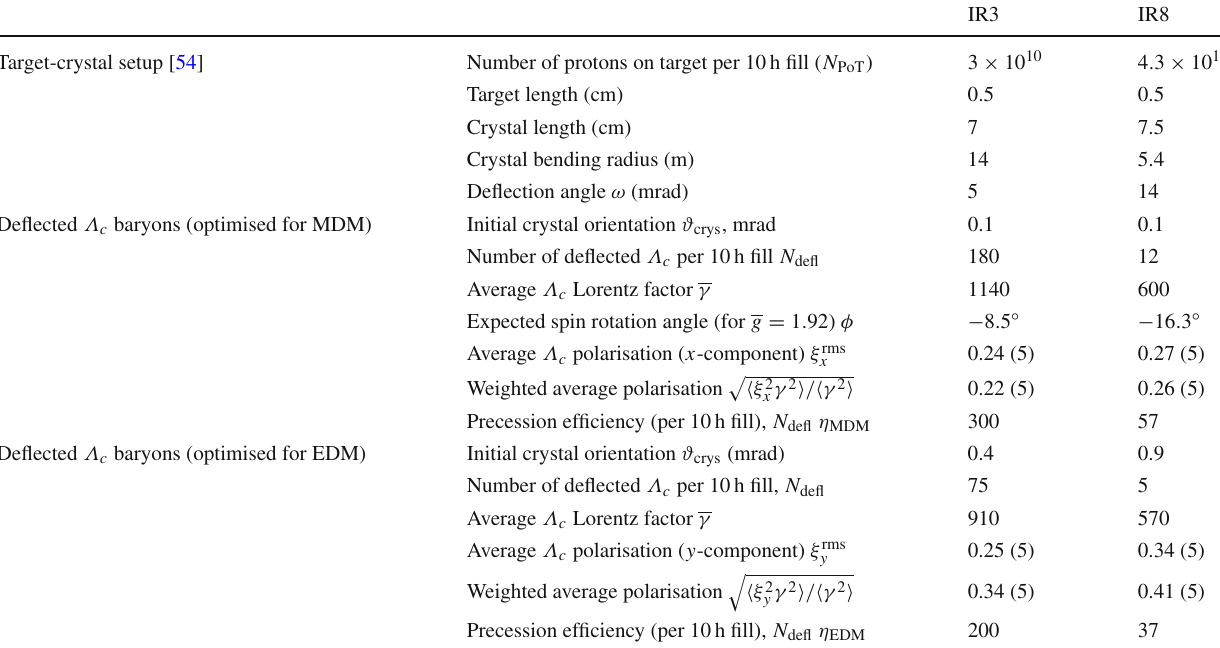
Fig. 3 Same as in Fig. 2. The areas highlighted with red and green show the phase spaces of Λ c baryons with spin precession in crystal caused mainly by MDM and EDM, respectively Table 1 Parameters of target-crystal setup and properties of deflected Λ c baryons at IR3 and